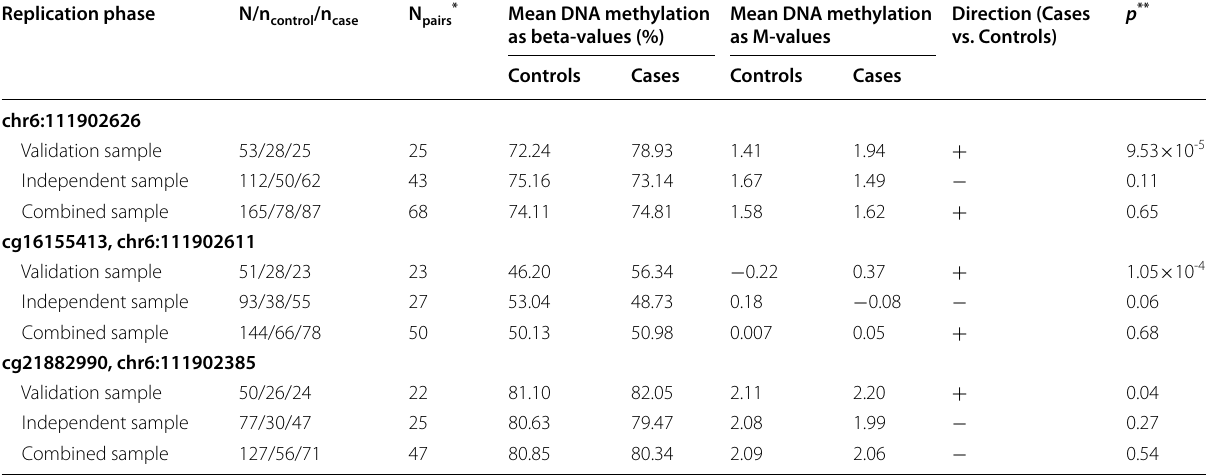
Table 5 Replication phase results examining trimester 3 DNAm data in the discovery (i.e., validation), replication, and combined